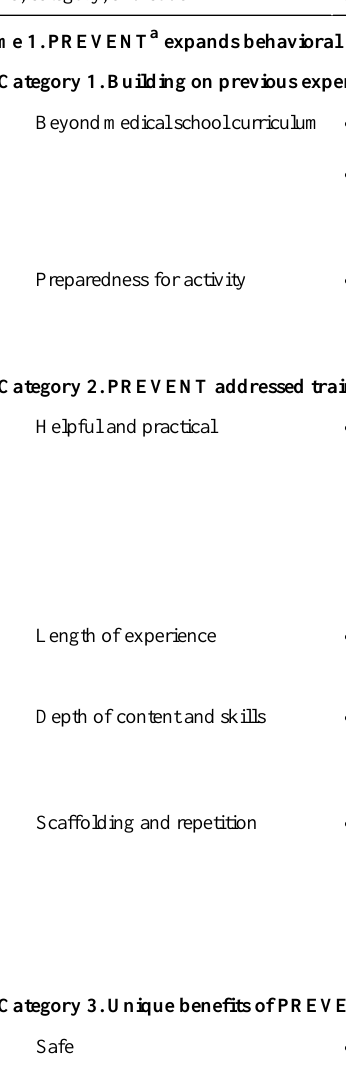
Supporting participant quotesTheme, category, and